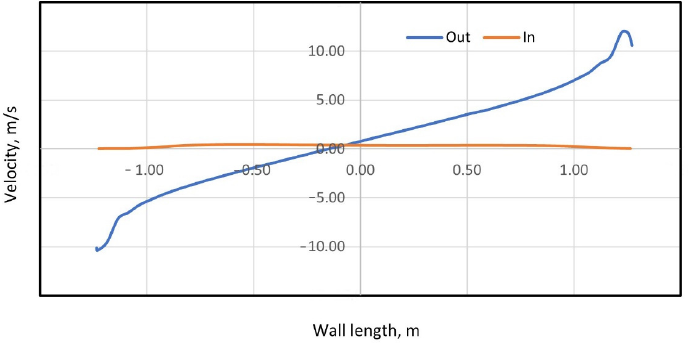
6 mm, the speed increased and stabilized.